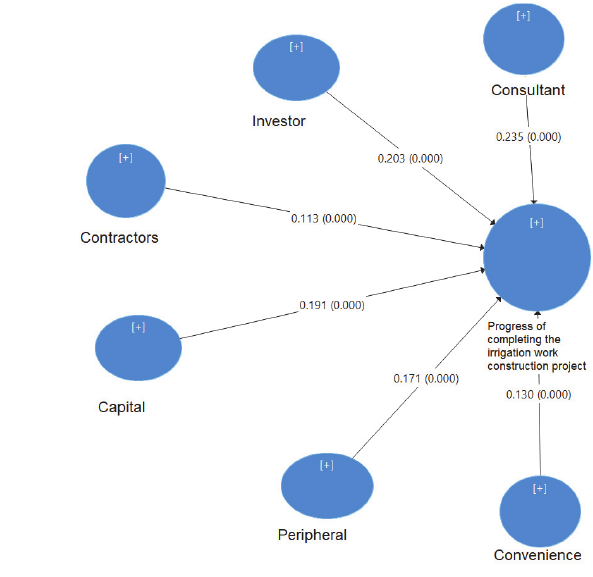
Fig. 2. The results of testing research